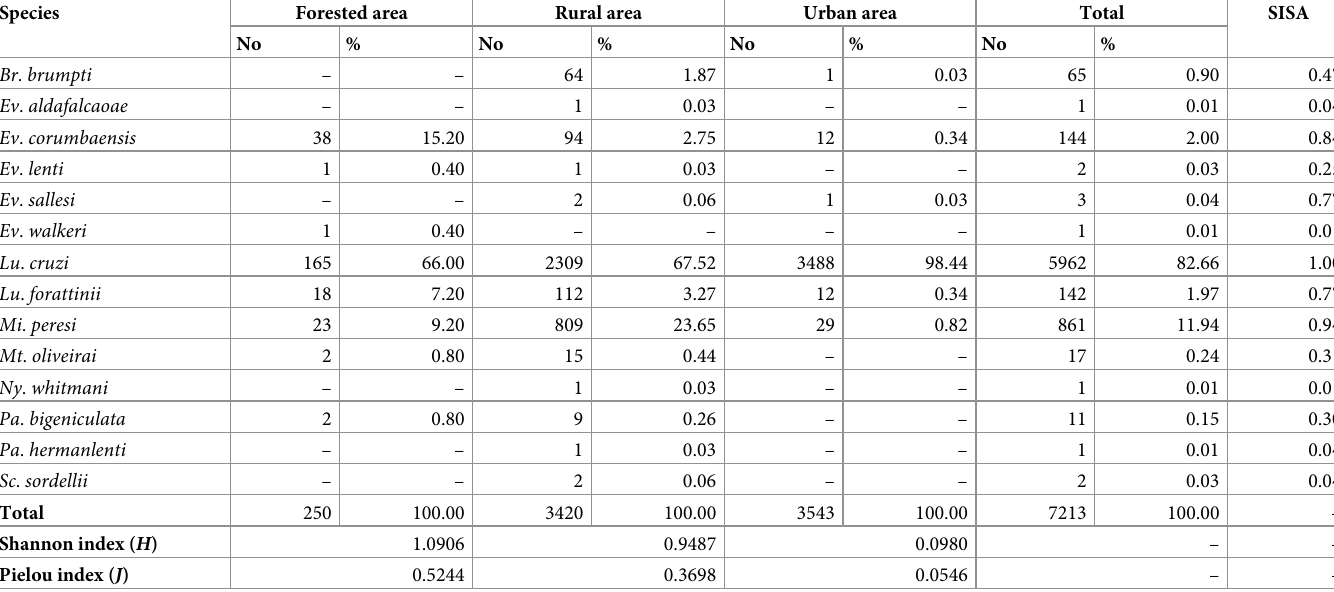
Table 2. Absolute and relative frequencies of sand fly species in forested ( n = 250), rural ( n = 3420), and urban ( n = 3543) areas and all three areas combined ( n = 7213). Shannon index ( H ), Pielou index ( J ), and standardized index of species abundance (SISA). Corumba´, Mato Grosso do Sul, Brazil. May 2015 to April 2017. Species